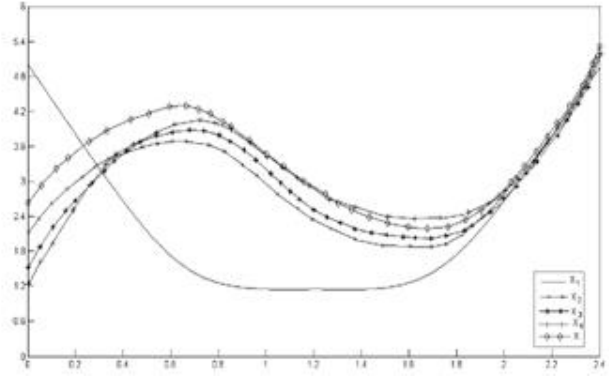
Figure 2. Random rate of the consecutive between-failures durations of the BP reformulated